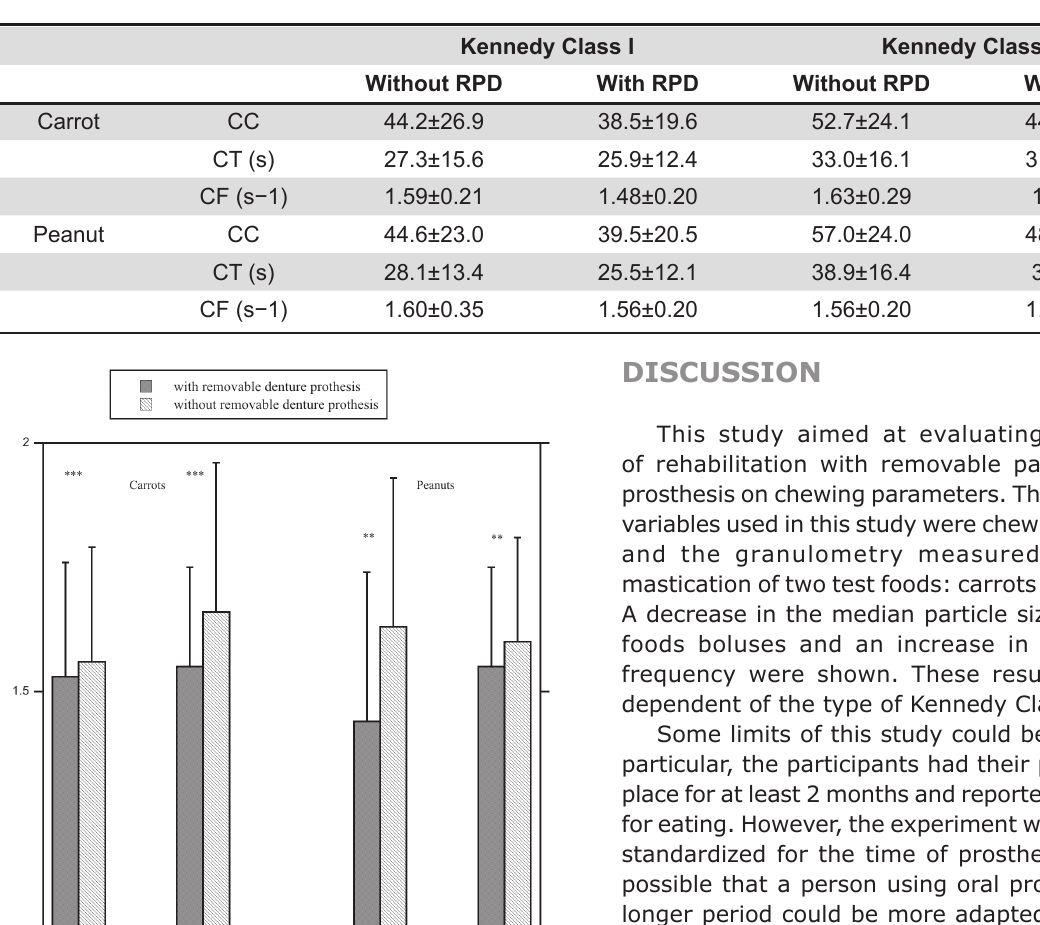
Table 1- Mean values ± standard deviation of the kinematics parameters of the carrot and peanut mastication (CC, number of chewing cycles; CT, chewing time; CF, chewing frequency with CF=CC/CT) with and without removable partial denture (RPD) rehabilitation and for each type of Kennedy